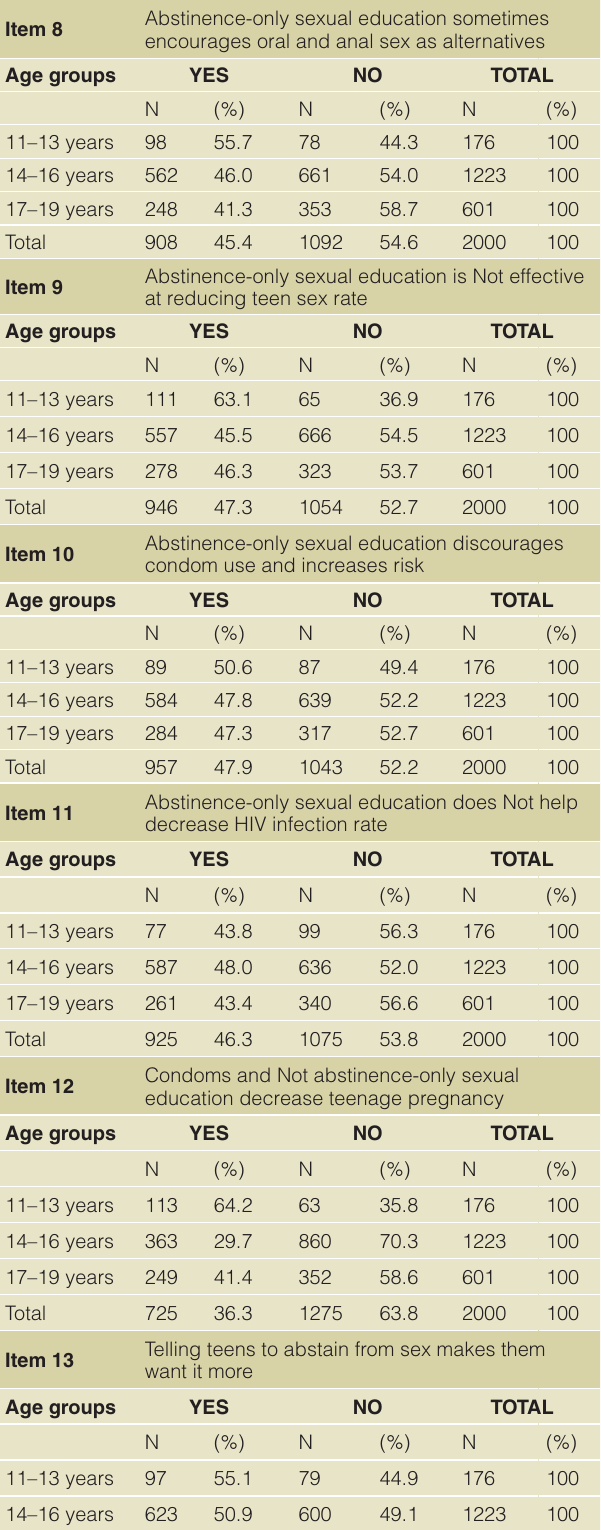
Table 3. Perspective of adolescents according to age group on the disadvantages of abstinence-only sexual